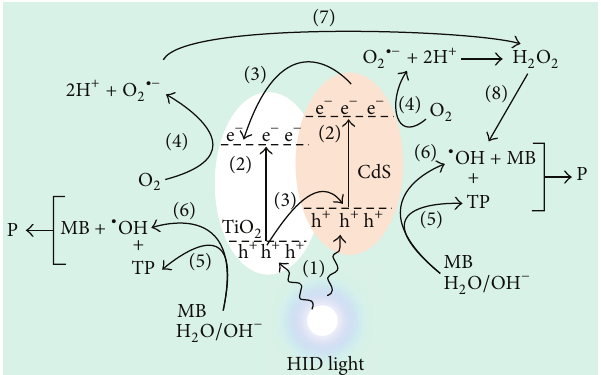
Figure 11: Scheme diagram of the photocatalytic reaction of MB on TiO 2